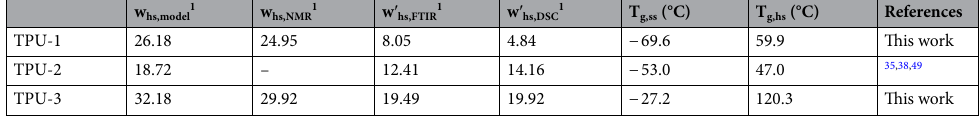
Table 6. The fundamental parameters in both experimental and theoretical approaches. 1 All parameters are in wt%.